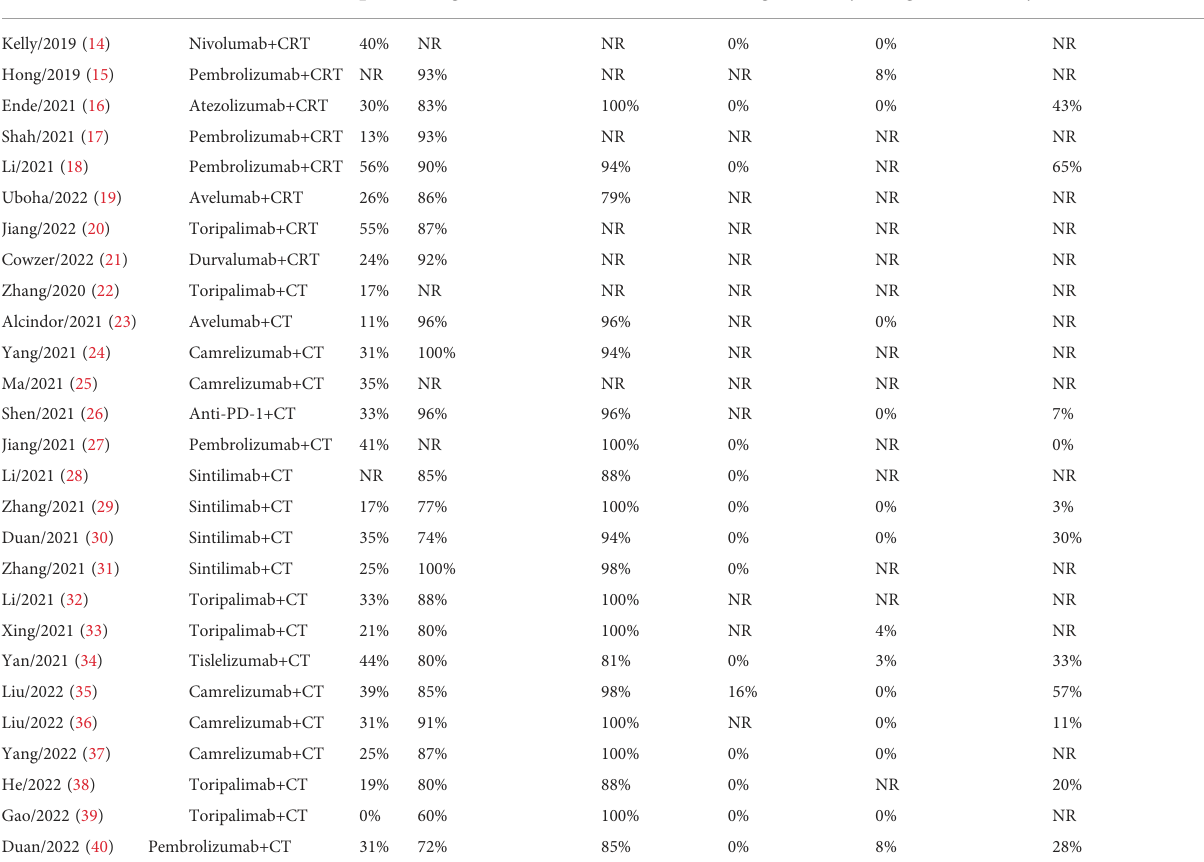
TABLE 2 Main outcomes of included